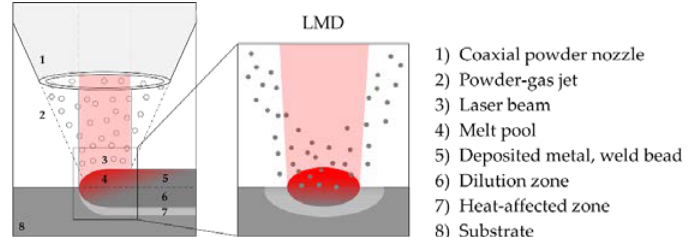
Figure 2. A diagram of the principle behind the LMD process [1]. Reprinted with permission from